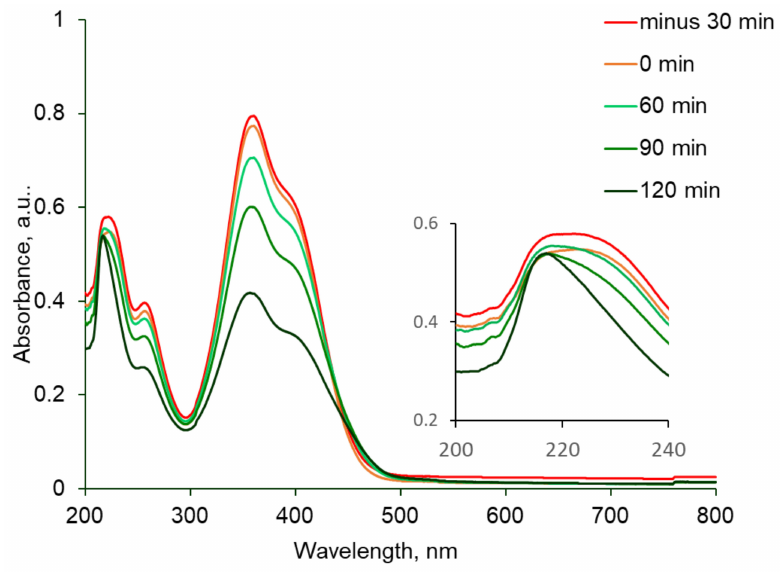
Figure 7. Temporal changes in UV-Vis absorption spectra for 2,4 DNP measured at the end of the adsorption reaction and during the photodegradation (20 mg/L) in aqueous solution in the presence of TiO 2 -Au/IWI (1